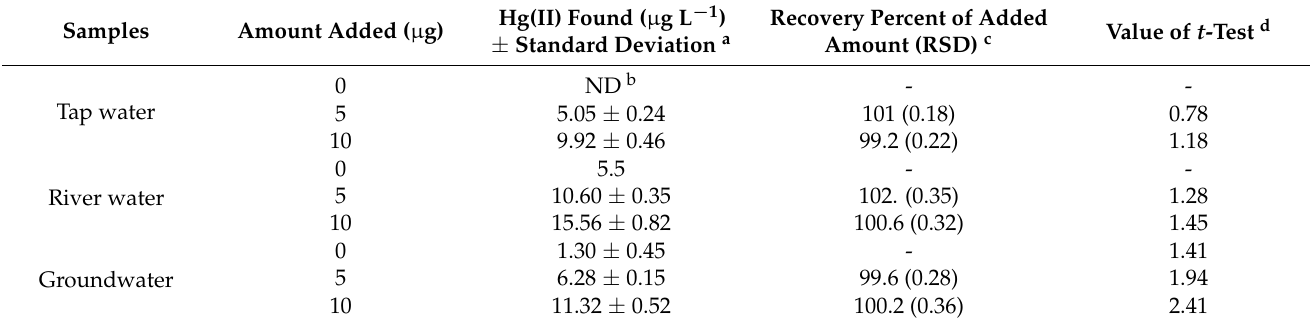
Table 4. Analyses of real samples after solid phase extraction using GO/CdS and ICP-OES determination.